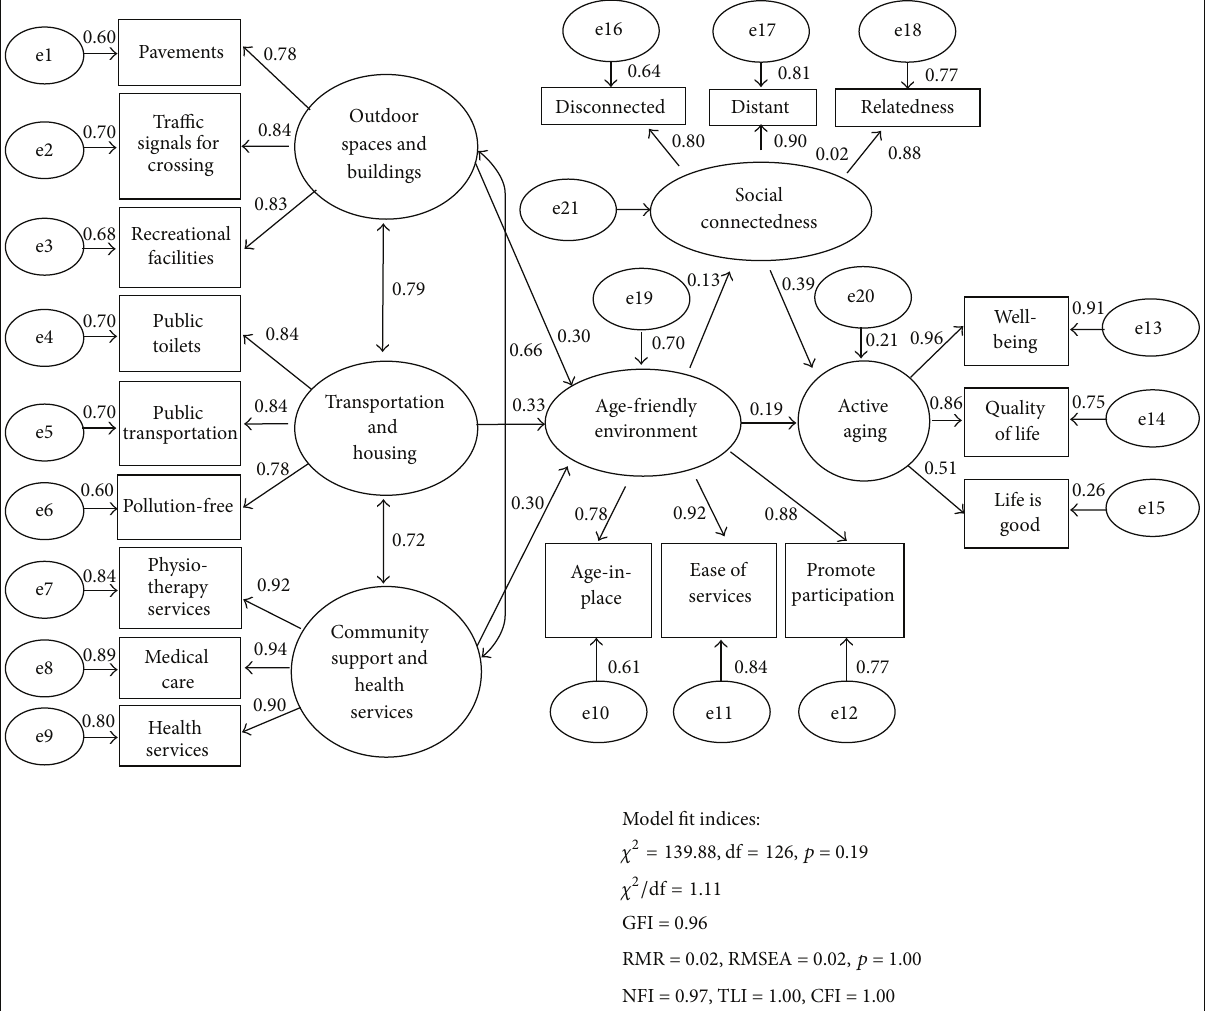
Figure 3: Overall structural model of age-friendly environment, active aging, and social